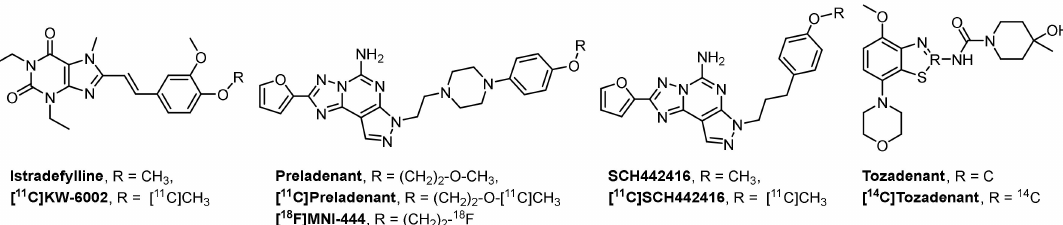
Figure 1. Representative adenosine A 2A receptor (A 2A R) antagonists and the corresponding radiotracers in clinical